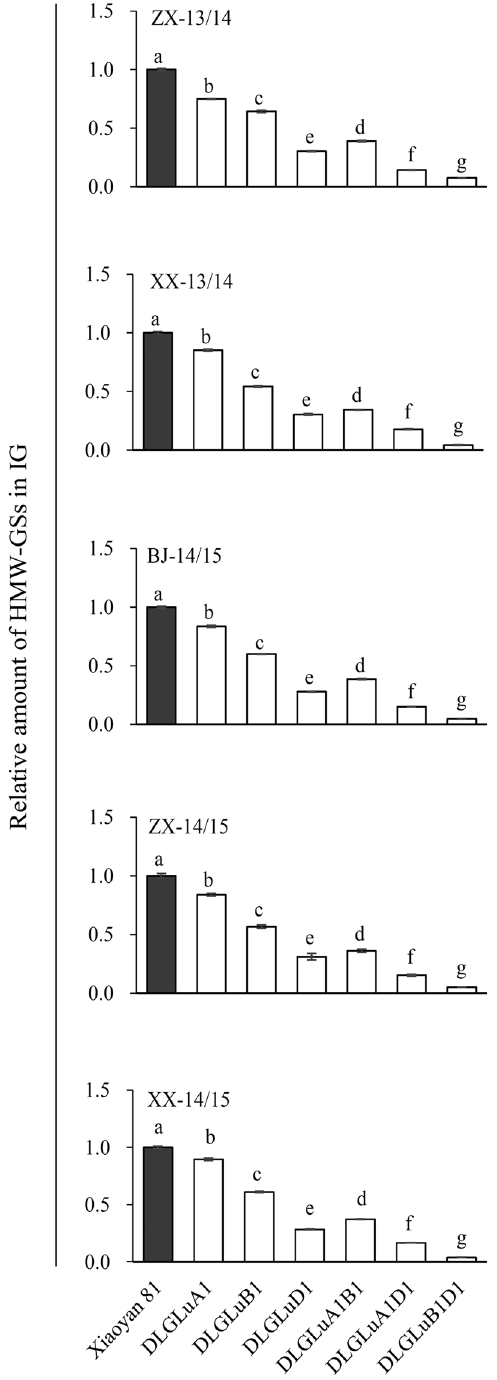
Figure 3. Reduction of HMW-GSs in IG in the six deletion mutants cultivated in five environments. The five environments were formed by growing Xiaoyan 81 and the six deletion lines (DLGluA1, DLGluB1, DLGluD1, DLGluA1B1, DLGluA1D1 and DLGluB1D1) in two locations (ZX and XX) in 2013/2014 and three locations (BJ, ZX and XX) in 2014/2015. The values presented are means ± SE of three separate tests, with that of Xiaoyan 81 being set as 1 to facilitate comparisons. In each environment, the means marked by different letters are statistically significant ( P < 0.05). BJ, Beijing; HMW-GSs, high-molecular-weight glutenin subunits; IG, insoluble glutenin; XX, Xinxiang; ZX,